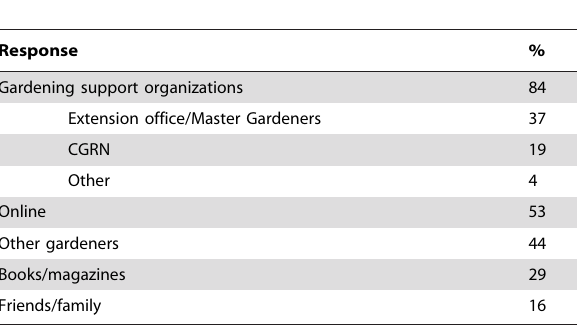
Table 5. Open-ended responses to ‘‘Where do you get information on gardening